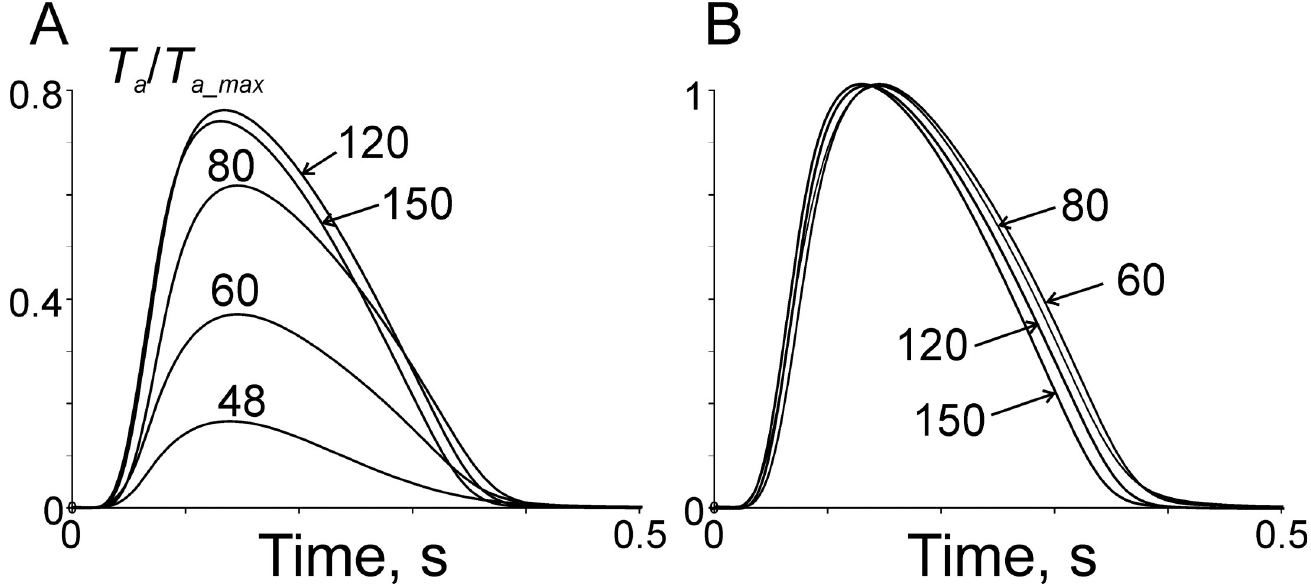
Fig 6. Calculated active tension during isometric twitches at different stimulations rates at sarcomere length 2.2 μ m. The rates are shown next to curves in min − 1 . A: active tension normalized for its maximal value at saturating Ca 2+ concentration; B: same calculated tension traces normalized for their peak values.